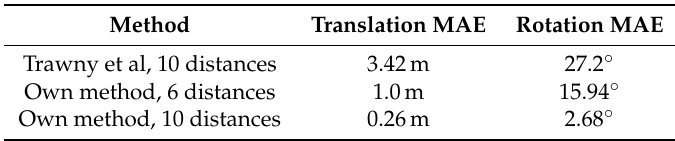
Table 2. Experimental mean absolute